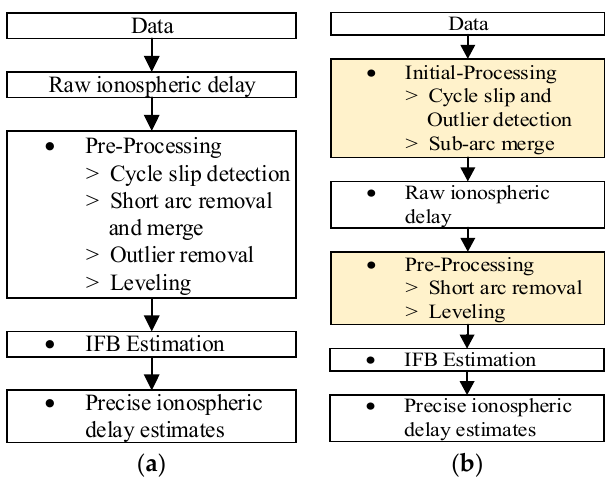
Figure 1. Procedure for the “Simple Truth” algorithm. ( a ) the traditional “Simple Truth” algorithm; ( b ) the improved “Simple Truth” algorithm.